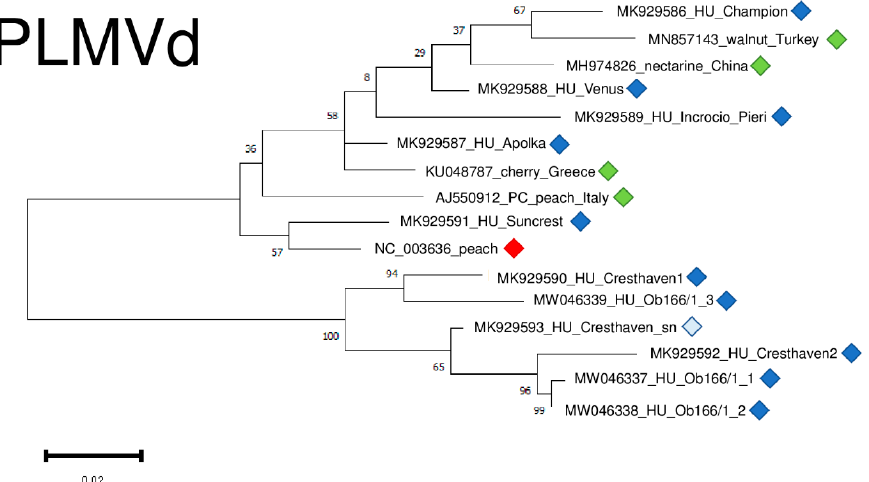
Figure 13. Evolutionary analysis of PLMVd variants, investigating whole genome sequences of different PLMVd isolates by Maximum Likelihood method. The evolutionary history was inferred by using the Maximum Likelihood method and Tamura-Nei model. The tree with the highest log likelihood ( − 1400.57) is shown. The percentage of trees in which the associated taxa clustered together is shown below the branches. Initial tree(s) for the heuristic search were obtained automatically by applying Neighbour-Join and BioNJ algorithms to a matrix of pairwise distances estimated using the Tamura-Nei model, and then selecting the topology with superior log likelihood value after 1000 Bootstraps. The tree is drawn to scale, with branch lengths measured in the number of substitutions per site. Alignment of the sequences was done using MUSCLE. Evolutionary analyses were conducted in MEGA11. Red box is the reference genome, green boxes indicate PLMVd strains from the NCBI GenBank, Hungarian PLMVd strains are indicated with dark blue (originating from the isolator house), light blue (originating from the open field stock nursery). The conserved regions in the hammerhead arm of the viroid responsible for its rep- lication are all maintained, together with the “kissing-loop” side chains (Figure 14).